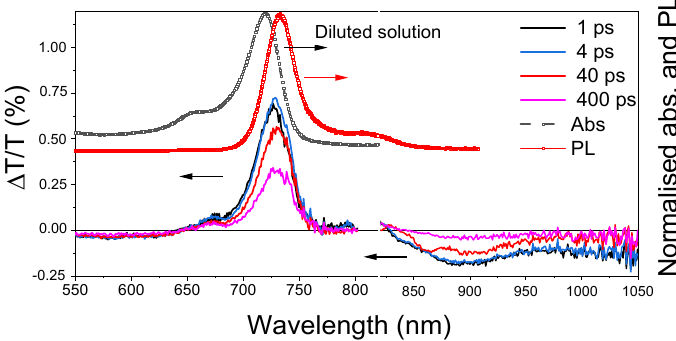
Figure 3. Absorption (red line + symbol) and PL (black line + symbol) spectra (translated vertically). Transient transmission spectra at different probe delays in the visible and NIR spectral regions. The positive band in the visible region represents the bleaching of the ground state overlapping with the stimulated emission at wavelengths larger than 720 nm. In the NIR region, a broad photoinduced absorption band with a peak at 900 nm is